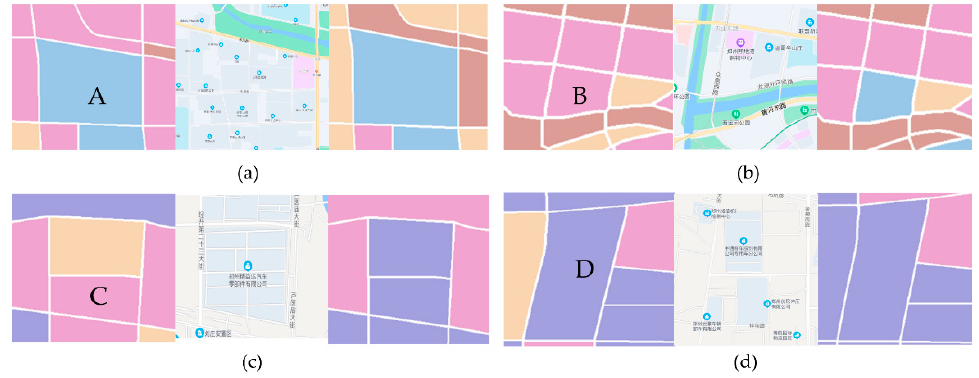
Figure 15. Comparison of partial identification results of Word2Vec with the actual function types and Baidu map: ( a ) area A of Figure 12a; ( b ) area B of Figure 12a; ( c ) area C of Figure 12a; ( d ) area D of Figure 12a.